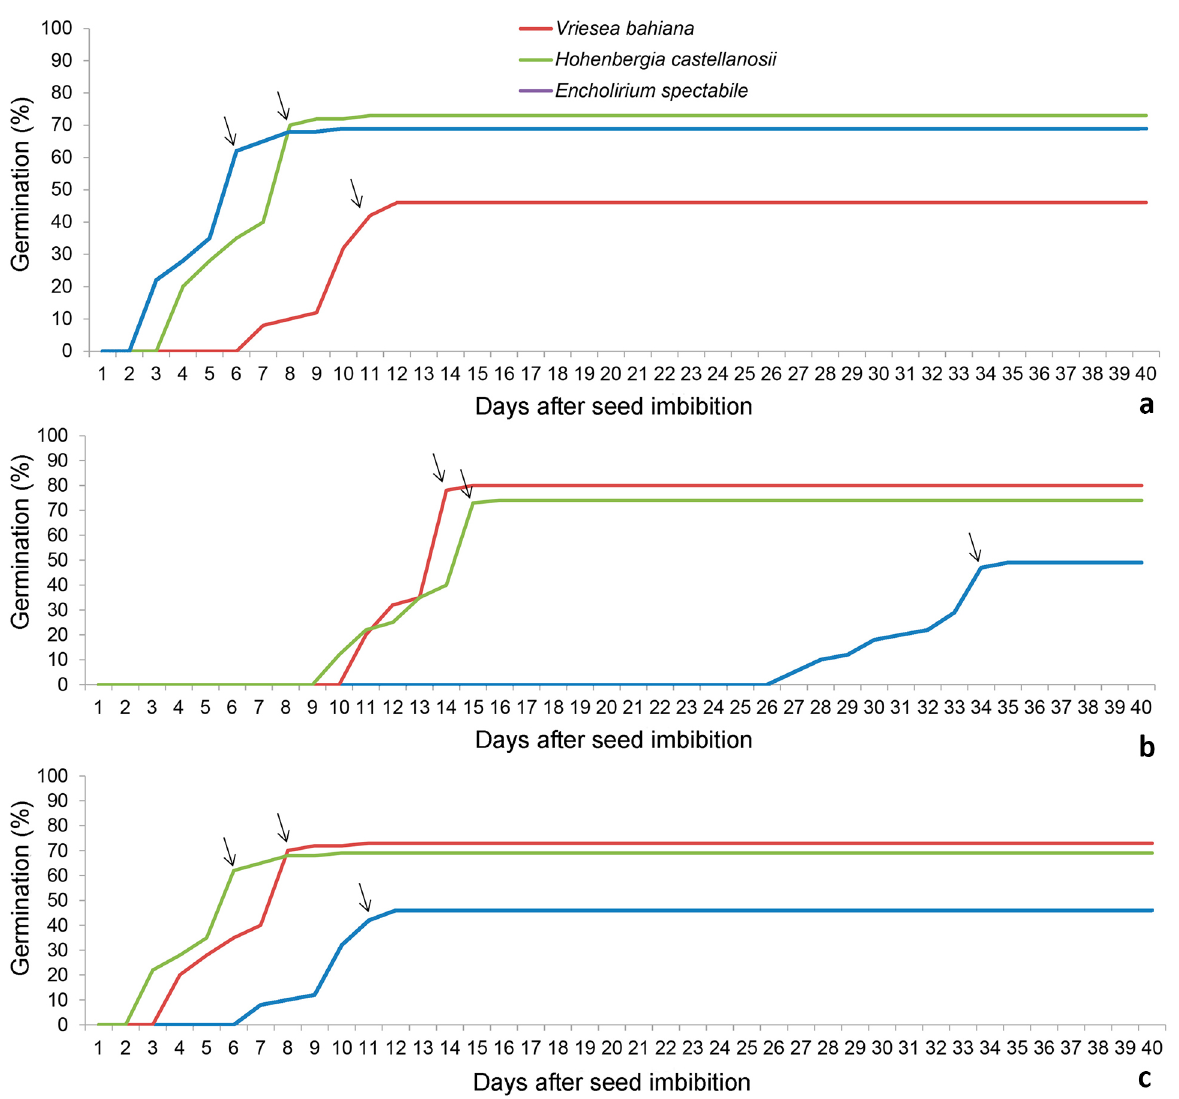
Figure 1. Cumulative germination percentage after moistening seeds of the three bromeliad species. a) Germitest ® paper; b) Vivato ® substrate; and c) washed sand. Arrows indicate the peak